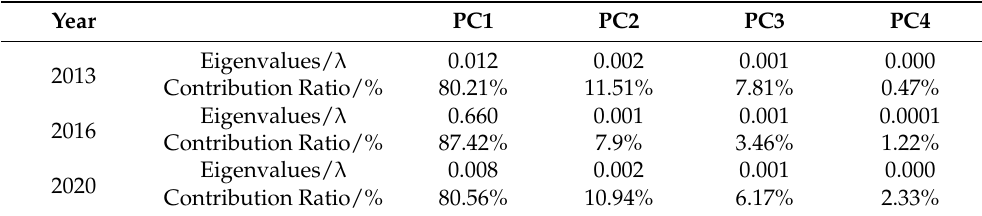
Table 1. Results of principal component